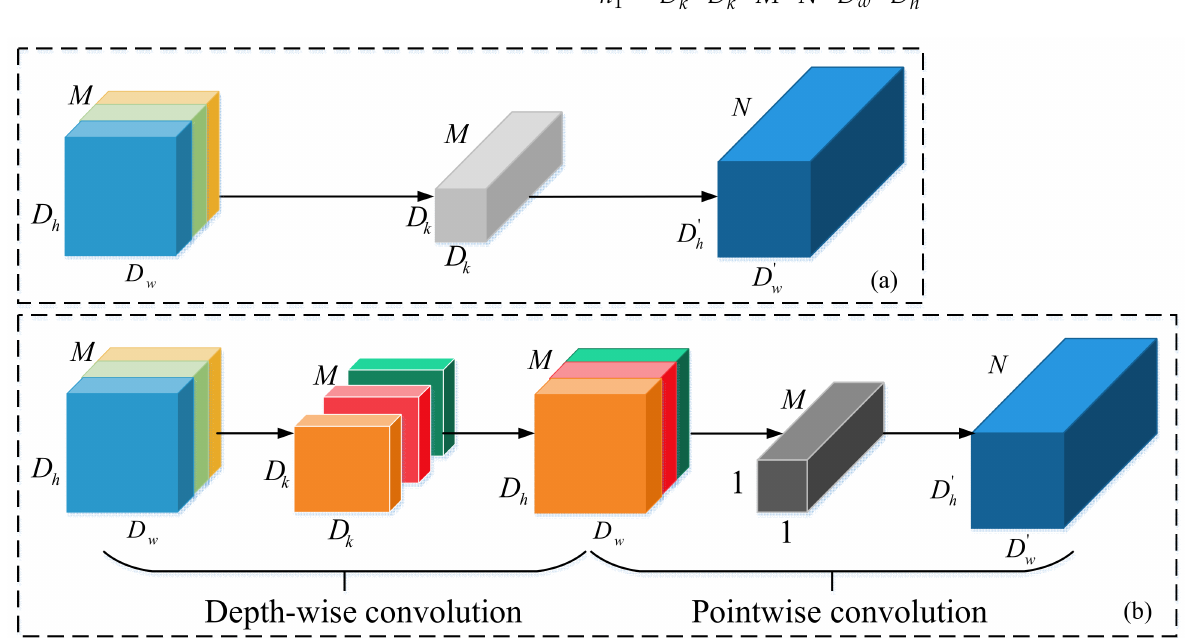
Figure 5. ( a ) Standard convolution process and ( b ) Depth-wise separable convolution